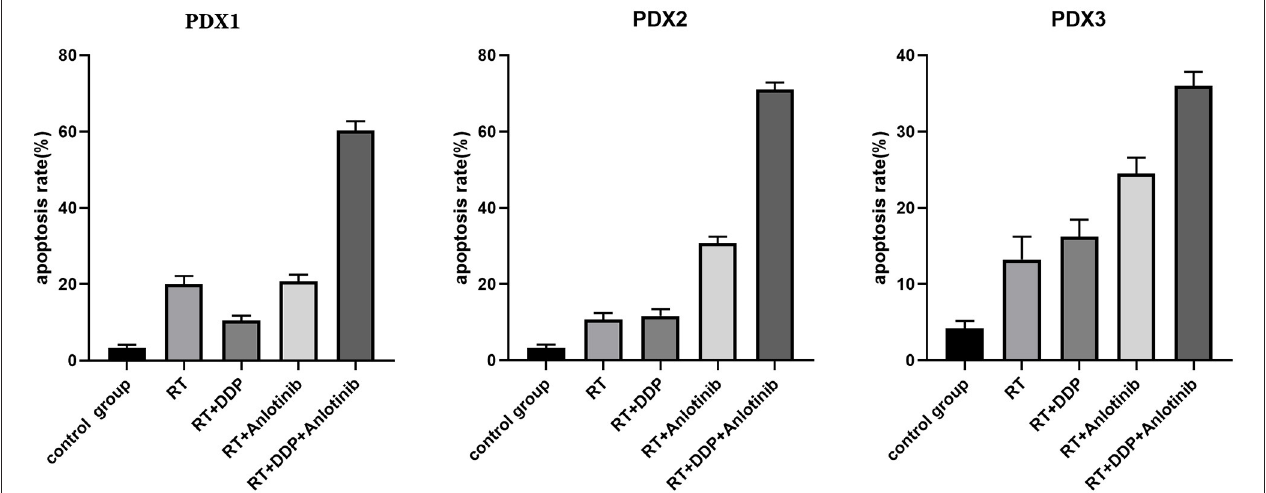
FIGURE 6 | The quantified apoptosis rates of different groups in patient-derived xenograft (PDX) models. The data are shown as mean ± SD . Compared with the control group, apoptosis rates at different degrees existed in four treatment groups, and anlotinib combined with chemoradiation-treated group had the highest apoptosis rate. RT, radiation therapy; DDP,